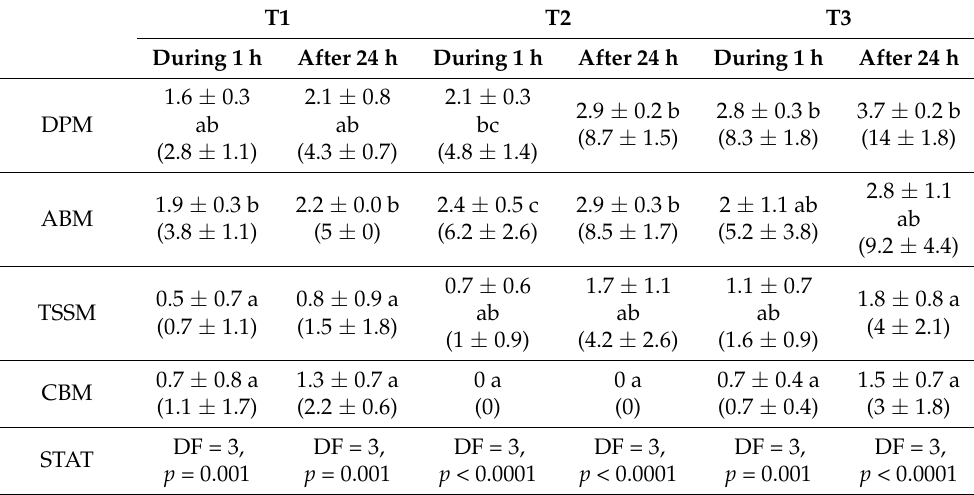
Table 4. Comparison of prey consumed by the predator S . gilvifrons among four pest species in each treatment during 1st hour of observation and after 24 h (parentheses represent mean ± std.dev of untransformed prey number